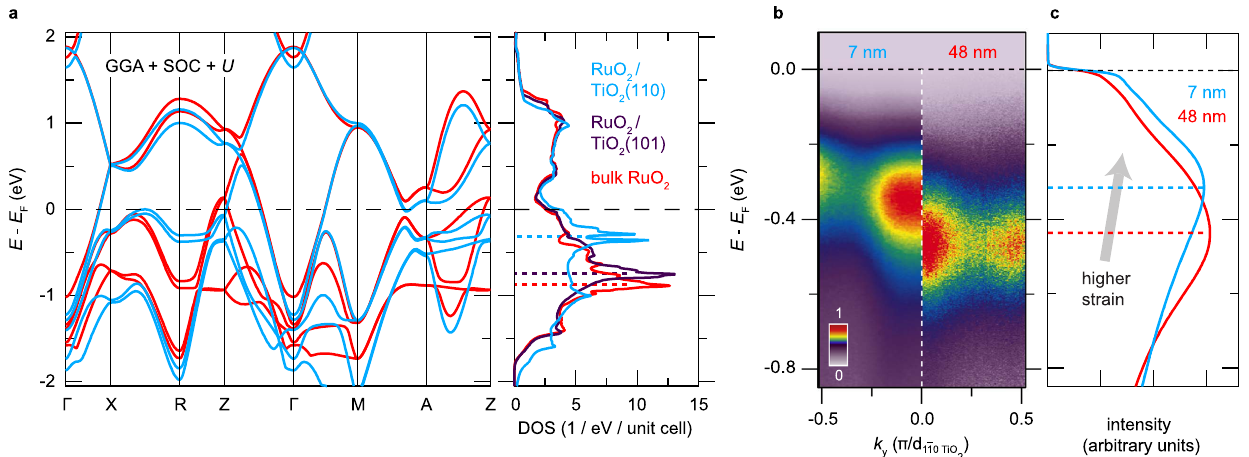
Fig. 4 Strain-induced changes to the electronic structure of RuO 2 . a DFT + U ( U = 2 eV) band structures and corresponding density of states (DOS) traces for bulk RuO 2 and epitaxially strained RuO 2 (110) and RuO 2 (101) thin fi lms. The RuO 2 (101) results are omitted from the spaghetti plot for clarity since they are very similar to bulk. b Comparison of E ( k ) spectra along the cut shown in Fig. 3e for two different RuO 2 (110) samples: a highly strained 7 nm thick fi lm (left), and a partially strain-relaxed 48 nm thick fi lm (right). The false color scale used to visualize the intensities in each spectrum is de fi ned and normalized in the same way as in Fig. 3. c As an approximate proxy of the total DOS, for these samples we plot the energy distribution curves of photoemission intensity averaged over the entire region of k -space probed experimentally with 21.2 eV photons (cf. Fig. 3c), which demonstrate that the epitaxial strains imposed by TiO 2 (110) substrates shift d ∣∣ states towards E F and thereby increase N ( E F